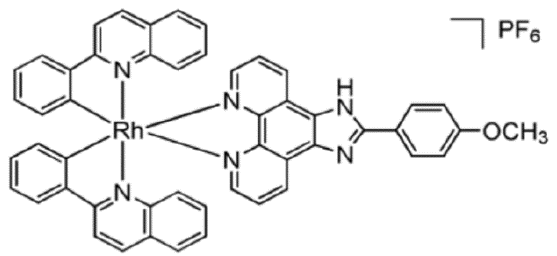
Figure 4. Chemical structure of rhodium(III) complex, a strong inhibitor of NEDD8-activating enzyme (NAE) [47].